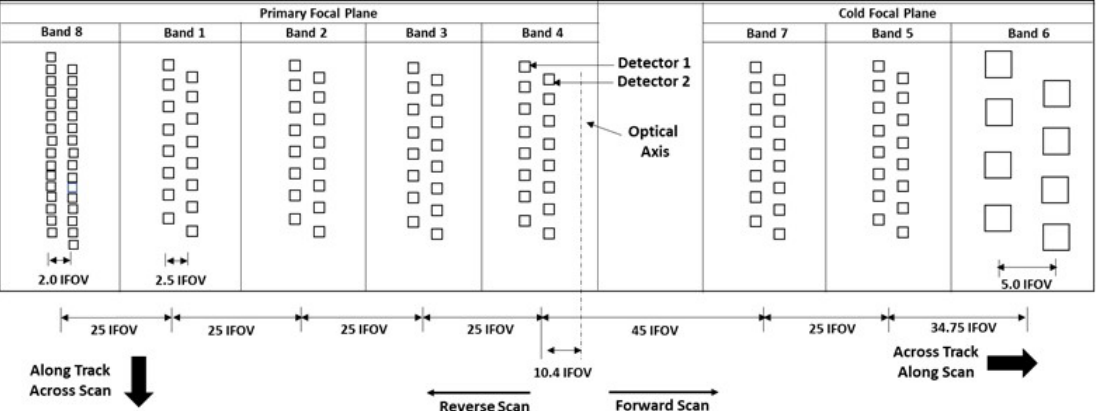
Figure 1. Enhanced thematic mapper plus (ETM+) focal plane layout. The pan band and its 32 detectors, the multispectral bands and their 16 detectors, and the thermal band and its 8 detectors are shown, along with the placement of these bands within the focal plane. Instantaenous Field of View (IFOV) refers to the instantaneous field of view for a multispectral detector. The designation of even detectors, whose number is divisible by 2, and odd detectors whose number is not divisible by 2, is used throughout the document.